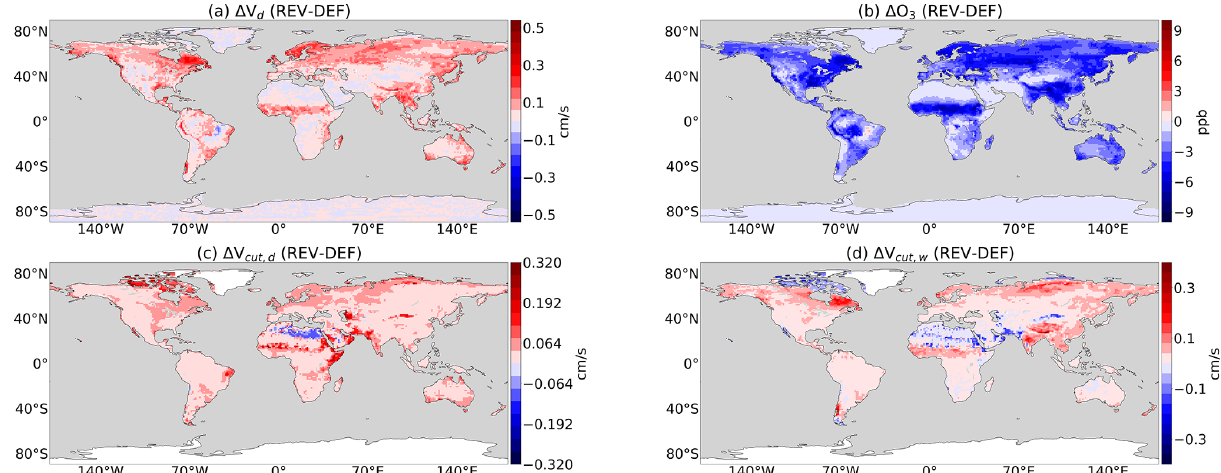
Figure 7. Multiyear (2010–2015) mean absolute changes in boreal summer: i.e. difference between the revised and default scheme (REV –